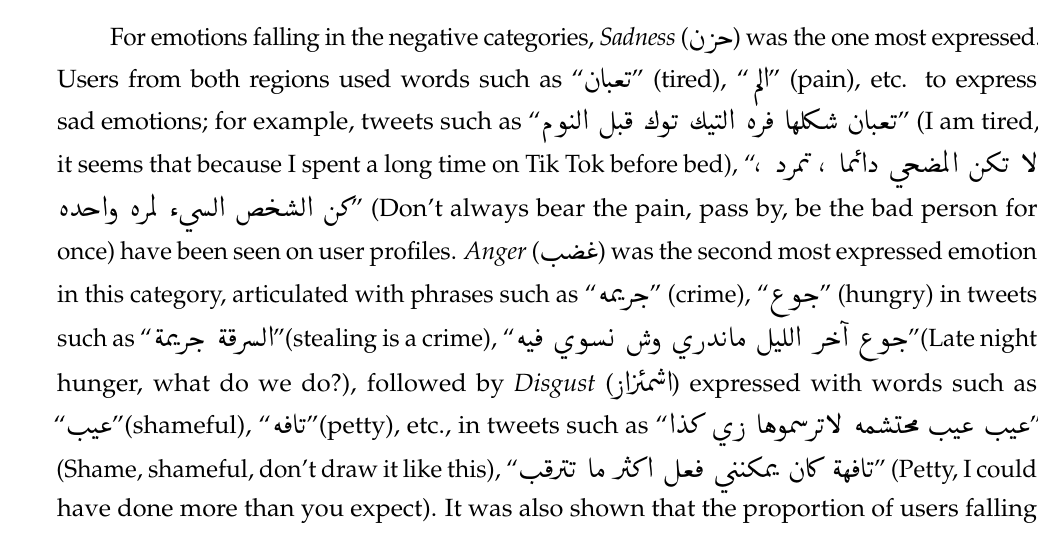
Figure 4. The proportion of user moods across Riyadh and Mecca.